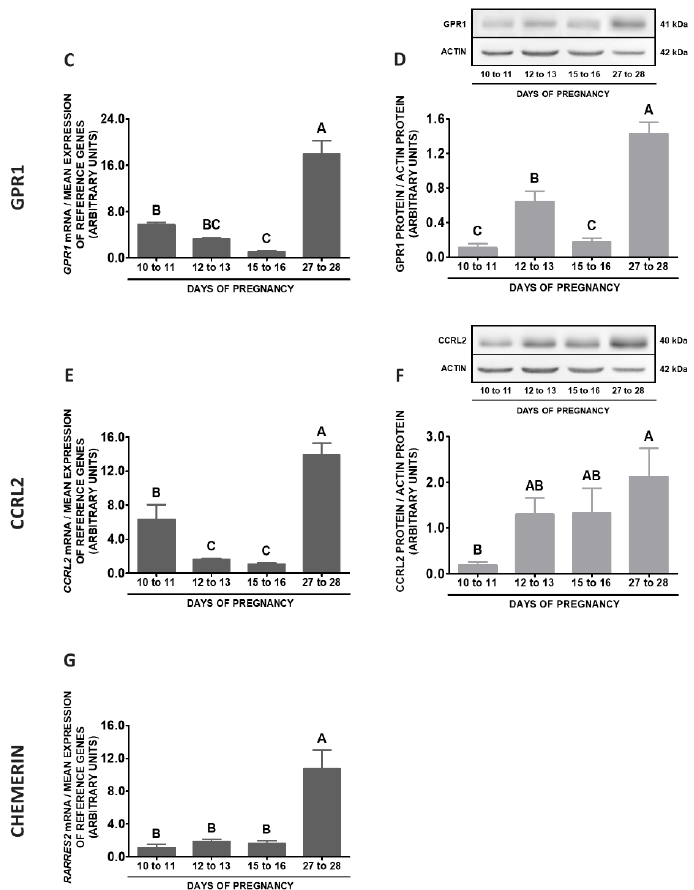
Figure 9. Chemerin system expression in the porcine preoptic area (POA) during early pregnancy. Gene and protein expression of chemokine-like receptor 1 (CMKLR1; A and B ), G protein-coupled receptor 1 (GPR1; C and D ) and C-C motif chemokine receptor-like 2 (CCRL2; E and F ), as well as chemerin ( RARRES2 ) mRNA content ( G ) in the porcine POA on days: 10 to 11, 12 to 13, 15 to 16 and 27 to 28 of pregnancy. Gene expression was determined by qPCR. Protein expression was determined by Western blotting; upper panels: representative immunoblots; lower panels: densitometric analysis of CMKLR1/GPR1/CCRL2 proteins relative to actin protein. Representative actin blots are identical for all chemerin receptors though proteins have been analysed on different gels. Results are presented as means ± SEM ( n = 5). Bars with different superscripts differ (one-way ANOVA at p < 0.05 followed by Tuckey post-hoc test at p < 0.05).